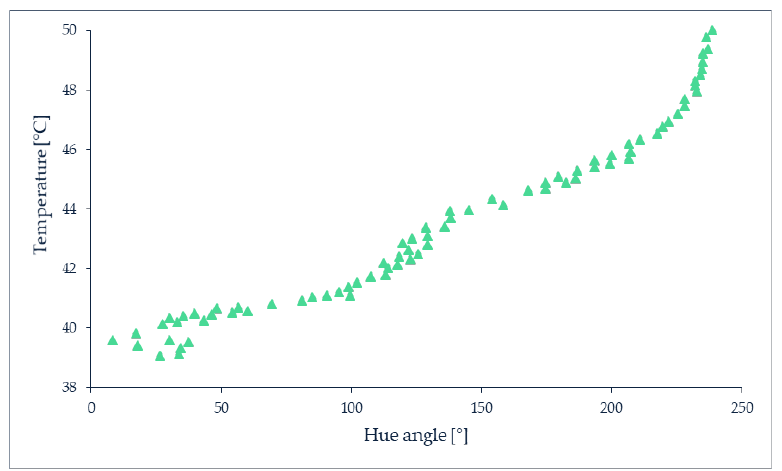
Figure 8. Typical calibration curve of TLC. Data from Muwanga and Hassan